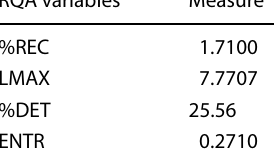
Table 3 RQA for the planetary K -index time series